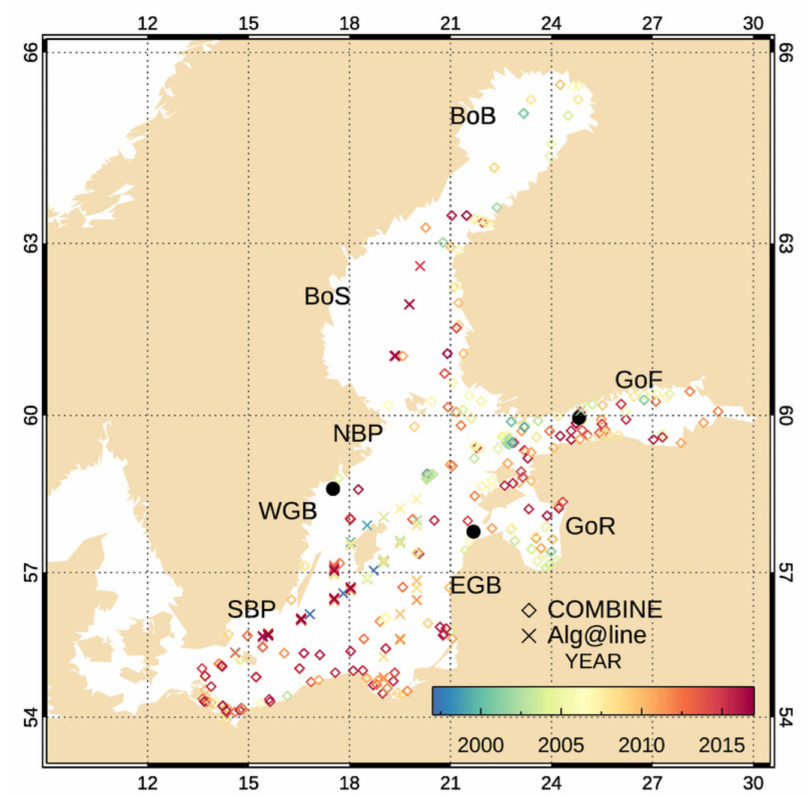
Figure 1. Study sites and location of the in situ match-ups. The crosses identify the in situ Alg@line data collected by the Finnish Environment Institute SYKE, whereas the diamonds are data extracted from the COMBINE database of the HELCOM marine monitoring programme. The black dots mark the location of the AERONET-OC sites. Abbreviations for the main sub-basins are: WGB (Western Gotland Basin); EGB (Eastern Gotland Basin); NBP (Northern Baltic Proper); SBP (Southern Baltic Proper); GoF (Gulf of Finland); GoR (Gulf of Riga); BoS (Bothnian Sea); and BoB (Bothnian